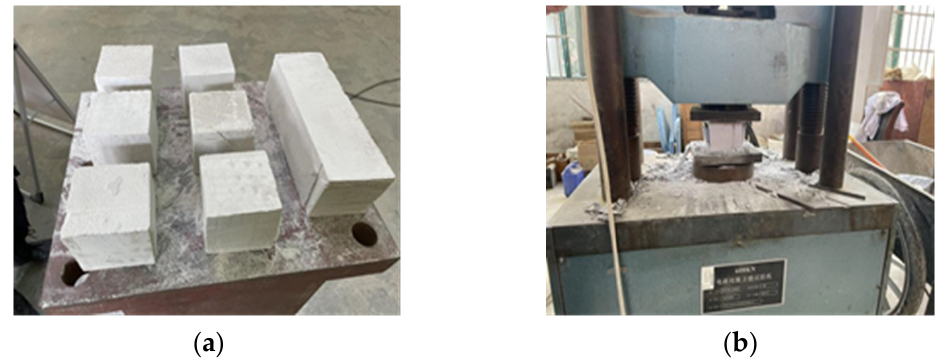
Figure 8. ALC compression test: ( a ) ALC specimens; ( b ) electric servo universal testing machine.